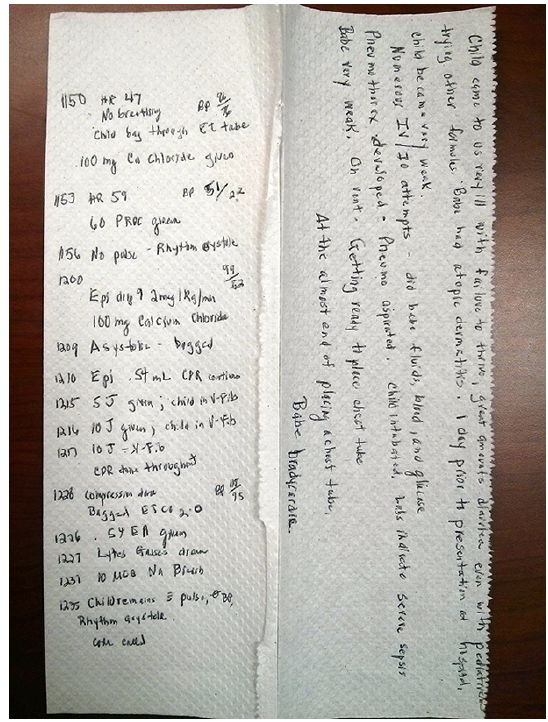
Fig. 3. A paper towel artifact from a recording nurse. Notes on the paper towel are later transferred to a code blue record or